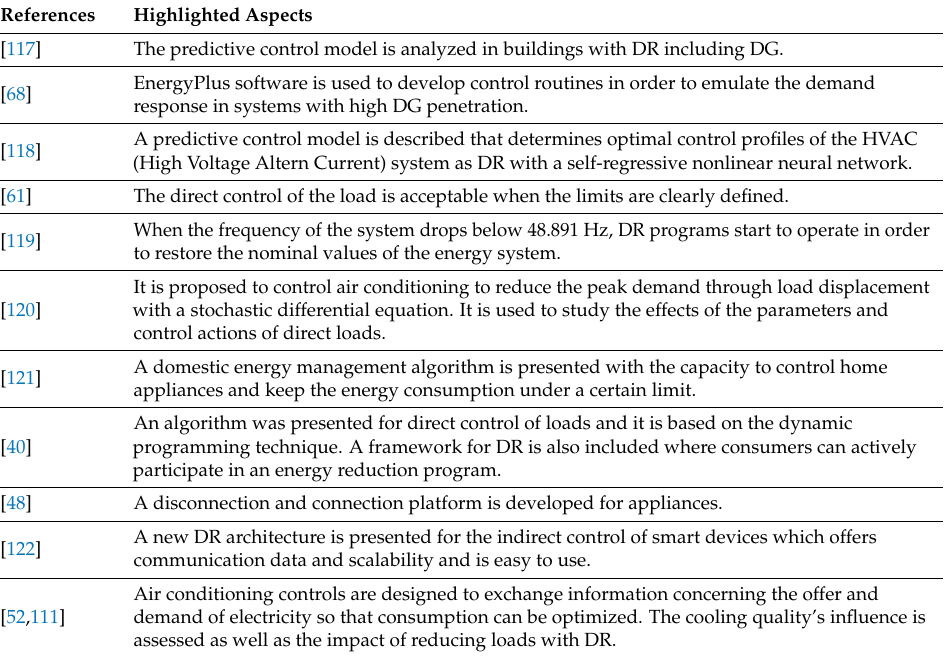
Table 6. DR from the automation